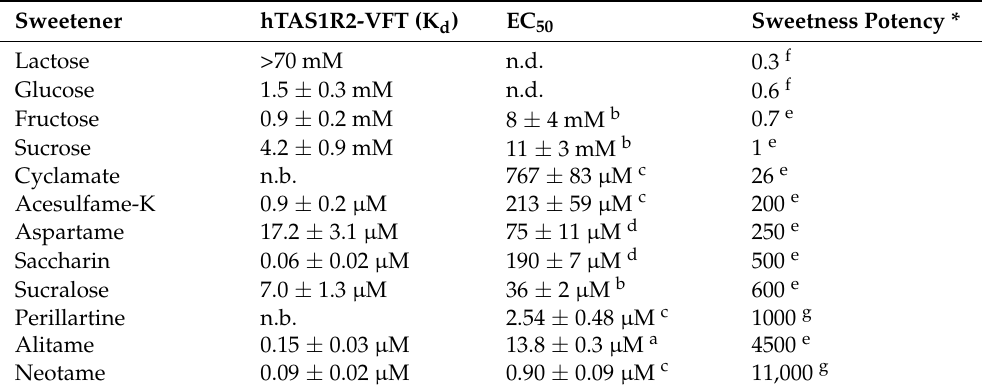
Table 1. K d values of hTAS1R2-VFT measured by intrinsic fluorescence for each sweetener compared to the EC 50 value obtained from cellular assays and estimated sweetness potency.